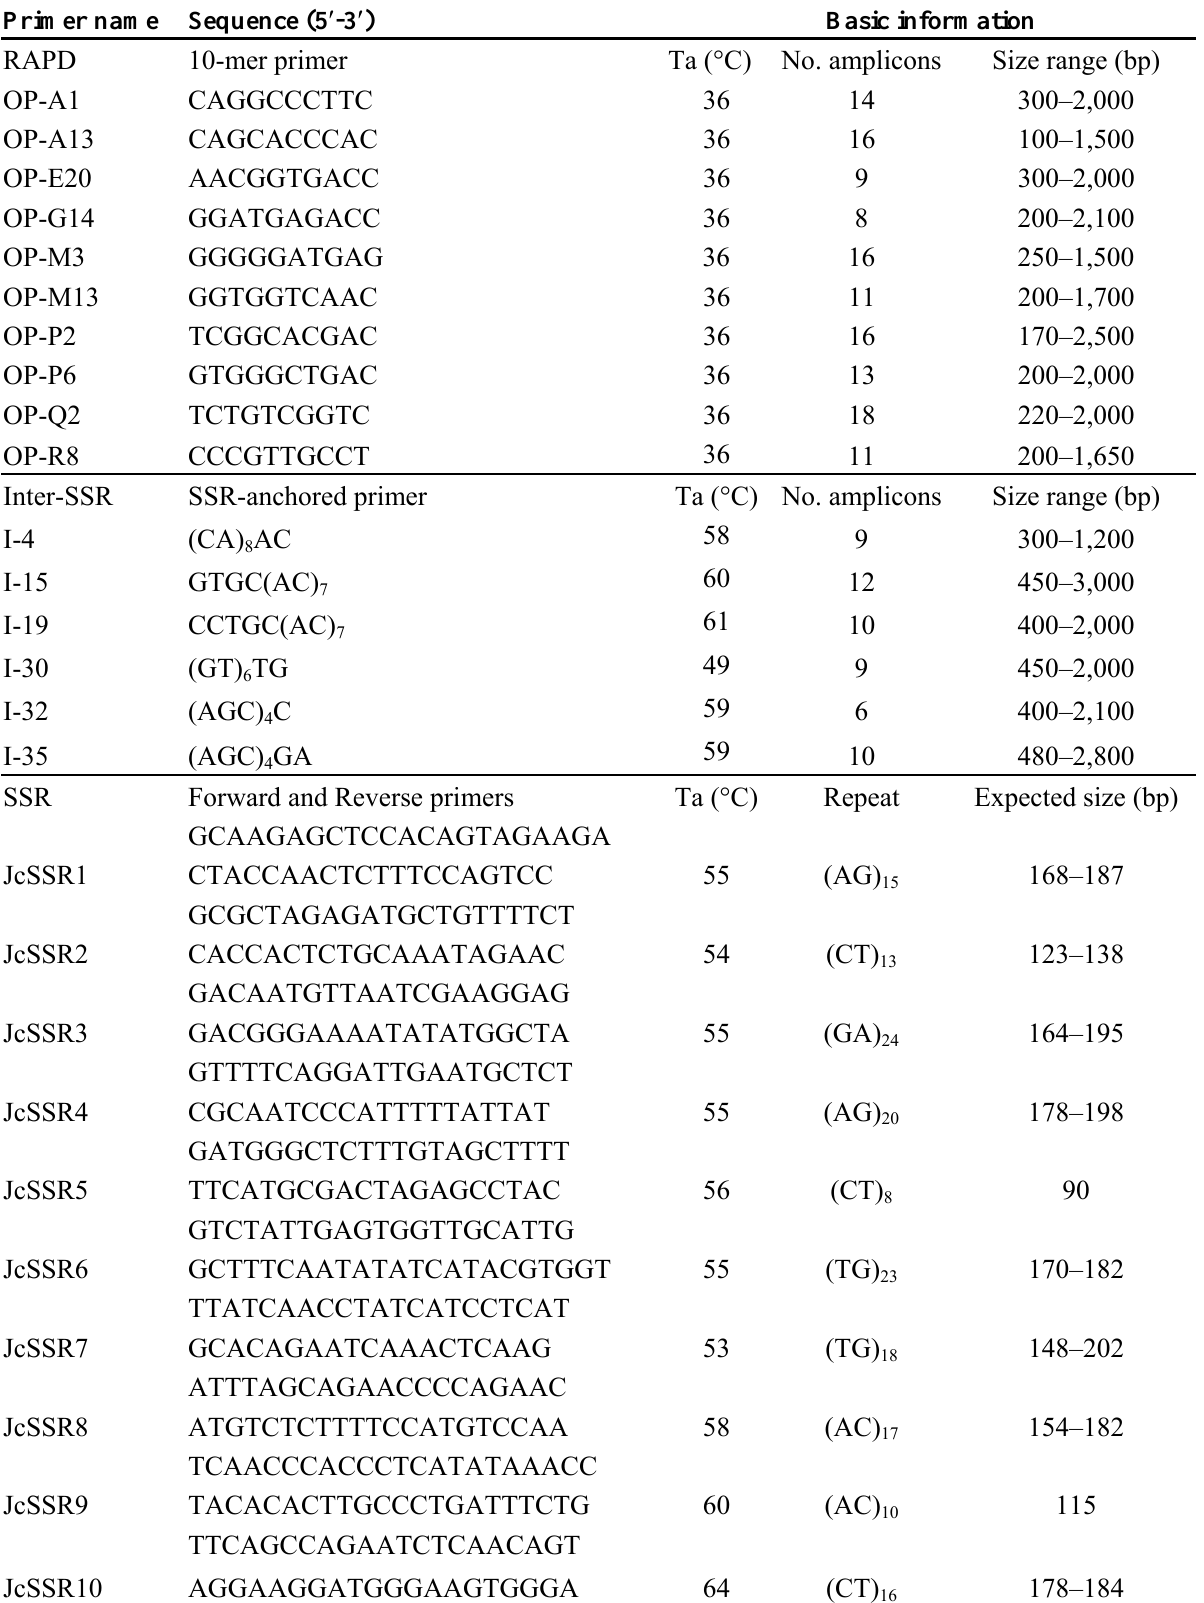
Table 2. List of primers used to detect RAPD, Inter-SSR, and SSR molecular